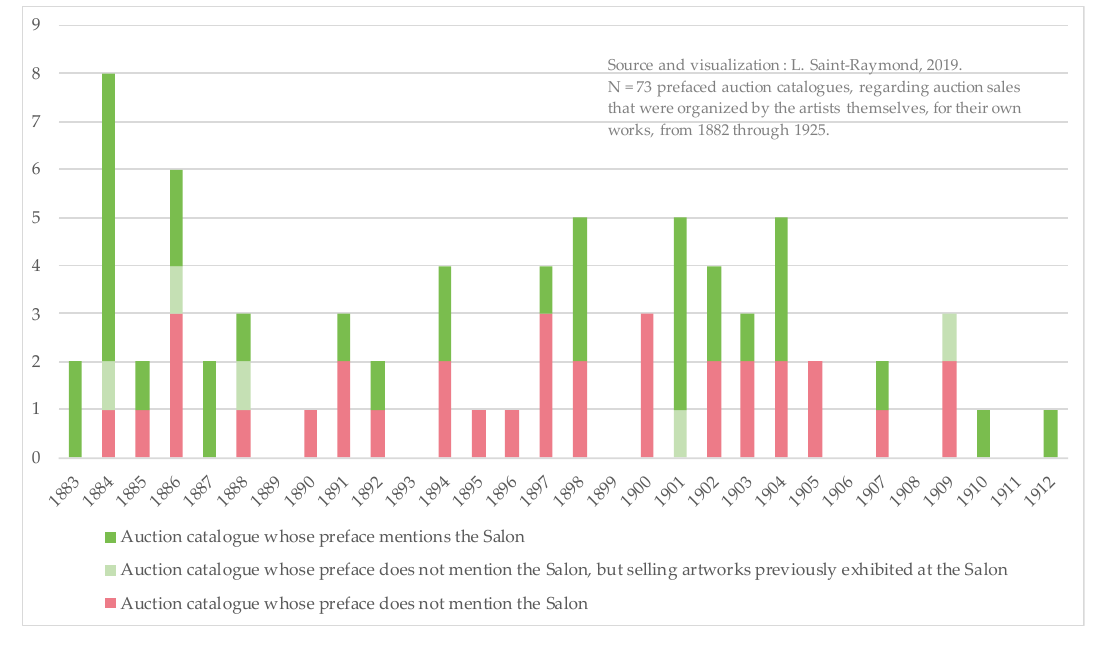
Figure 5. Mentions of the Salon in prefaced auction catalogues, for the artists who organized a sale of their own works, from 1881 through 1912. (Used by permission).